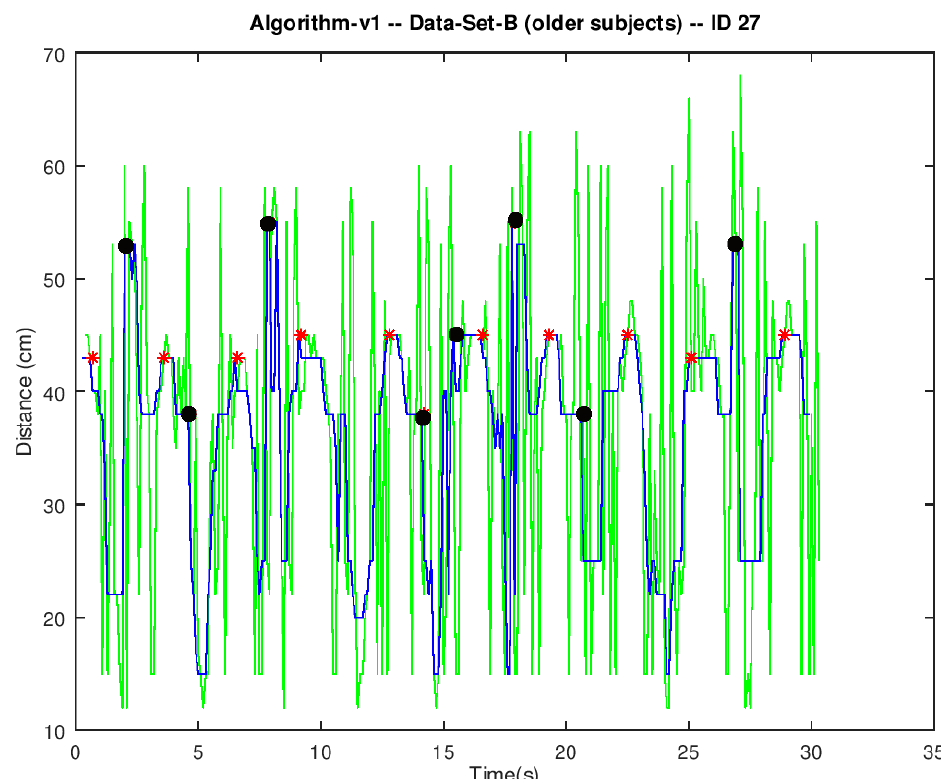
Figure 5. Graphical representation of a signal from dataset B (older subjects) and the outcomes resulting from processing it with Algorithm-v1. The green line represents the pre-processed signal after removing all the outliers over a given threshold. The blue line represents the output of applying a moving median filter to the green signal. The red dots represent legitimate sit-to-stand transitions identified and reported by the algorithm. The black dots represent sit-to-stand transitions erroneously identified and reported due to the effect of the spurious spikes in the green signal.